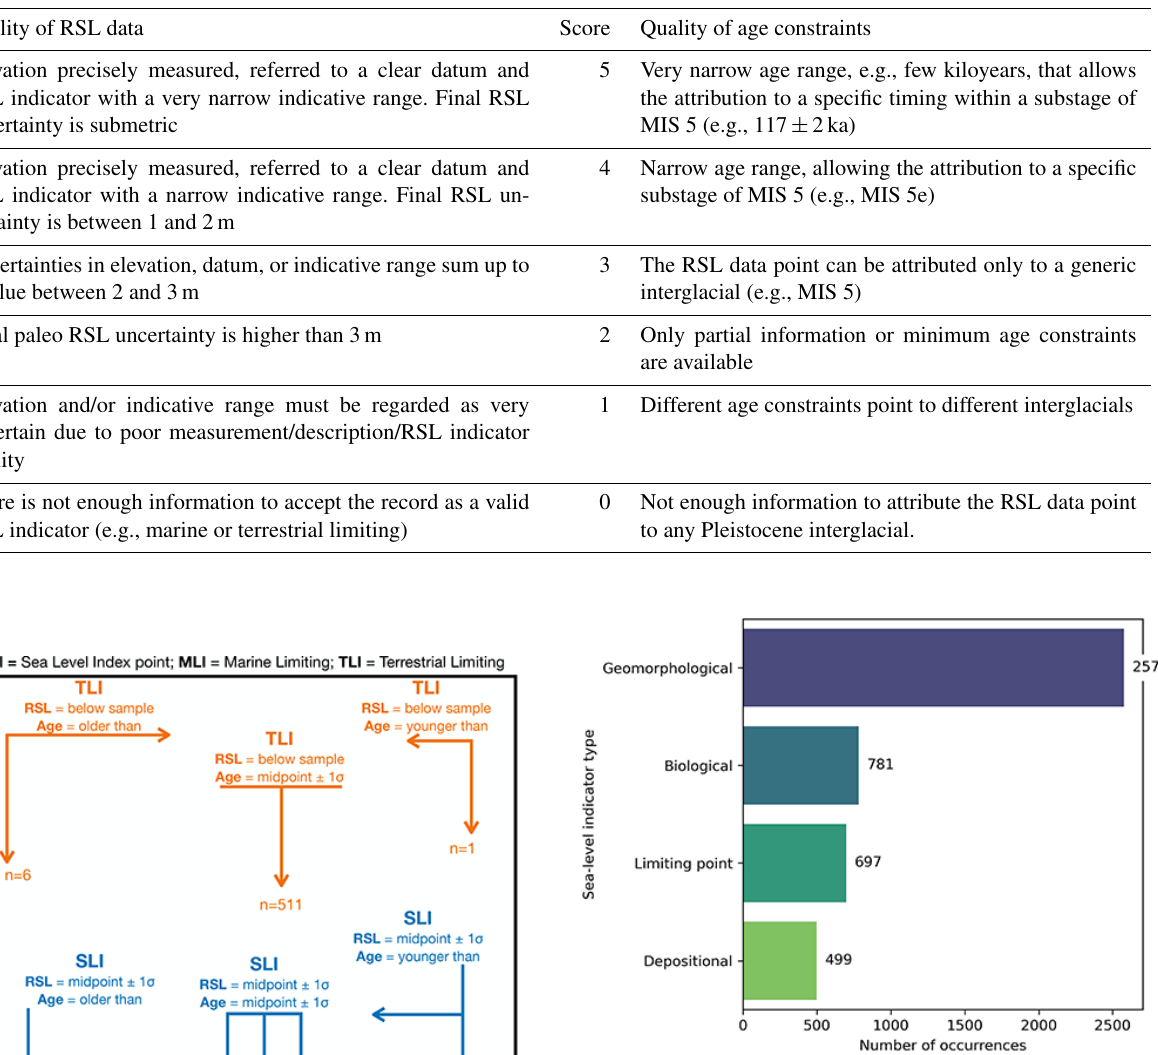
Table 3. Quality scores as suggested by the WALIS guidelines (verbatim from Rovere et al., 2020, originally published under the CC-BY 2.0 license). Scores vary from 0 (rejected) to 5 (excellent).